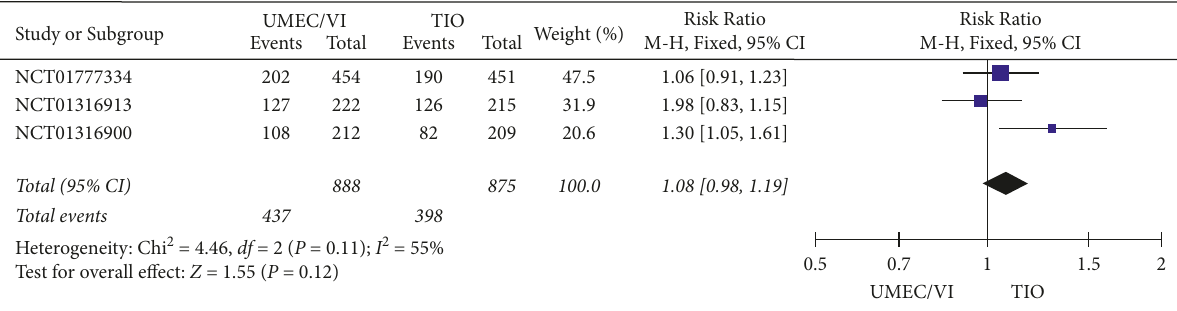
Figure 4: Forest plot of adverse event results for UMEC/VI vs. TIO using random-effects meta-analysis. TIO